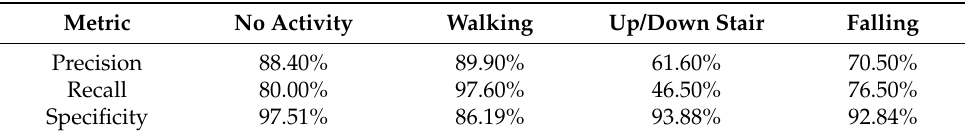
Table 3. Results of the metrics computed from the confusion matrices in the LSTM algorithm.